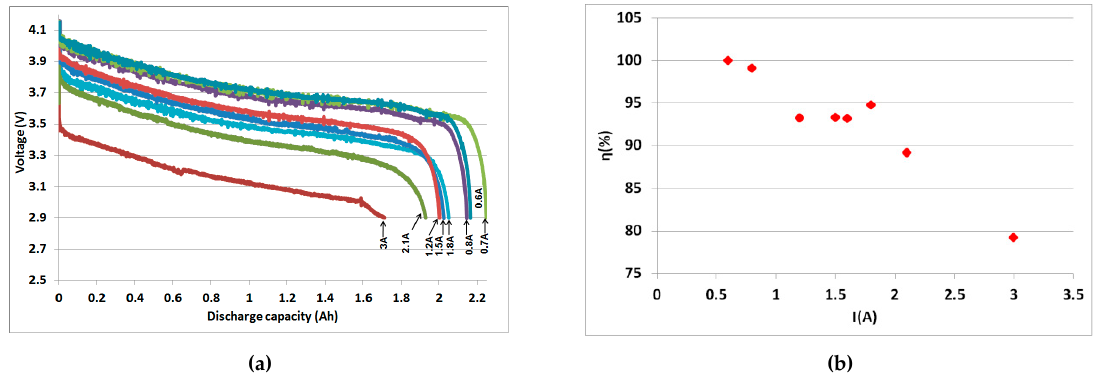
Figure 8. Battery capacity at different discharge currents ( a ) voltage response ( b ) Coulombic efficiency.